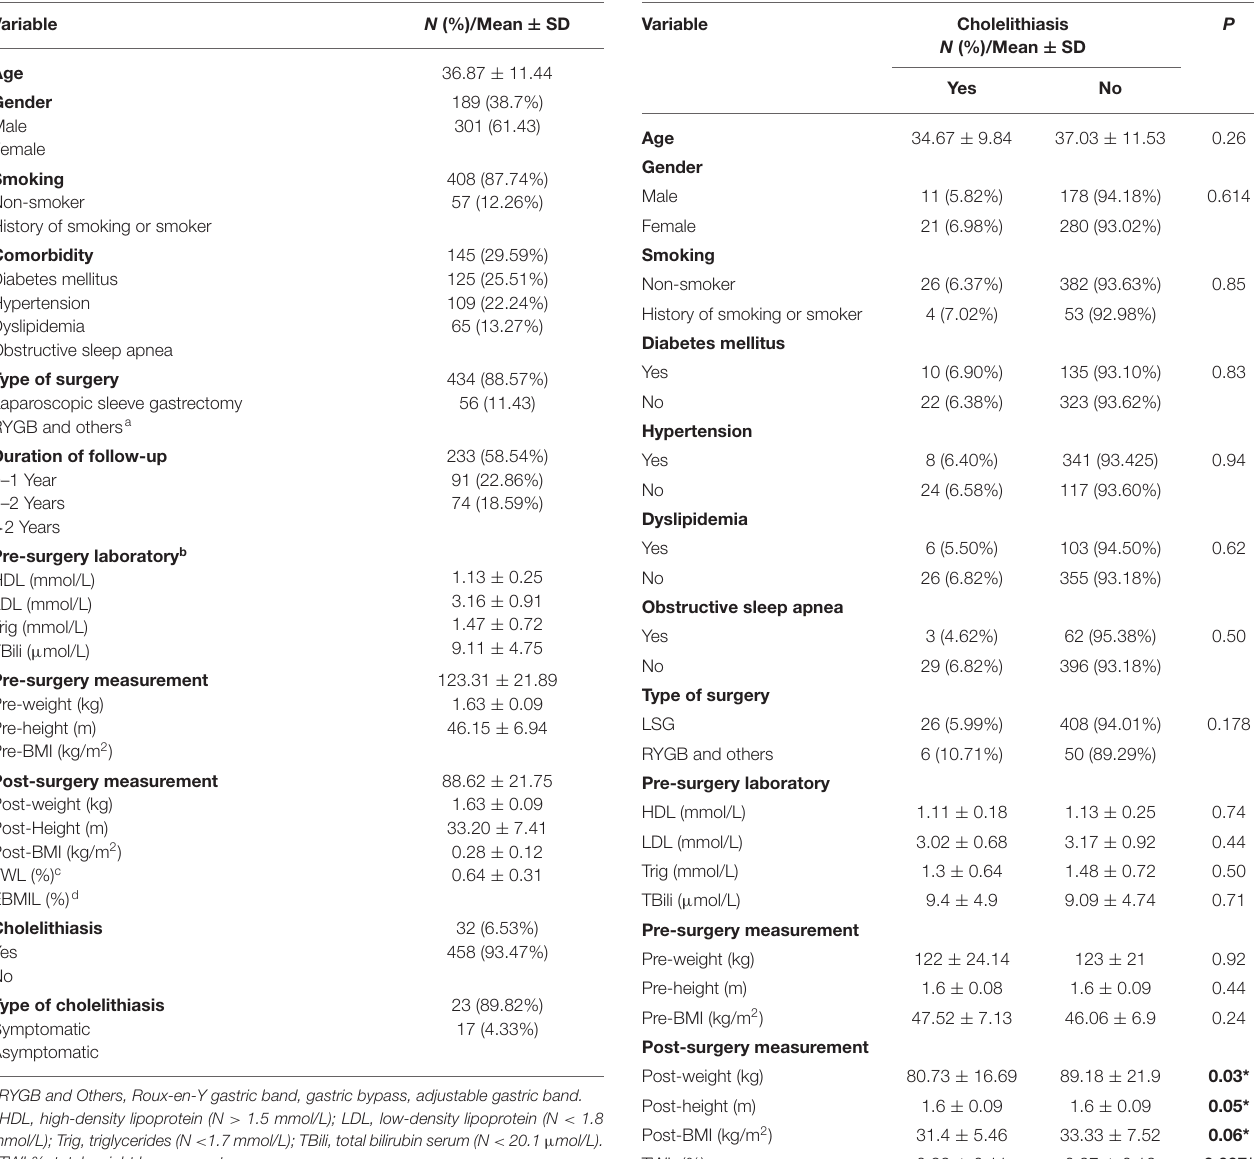
TABLE 1 | Baseline characteristics of bariatric surgery patients. TABLE 2 | Association between cholelithiasis and possible risk